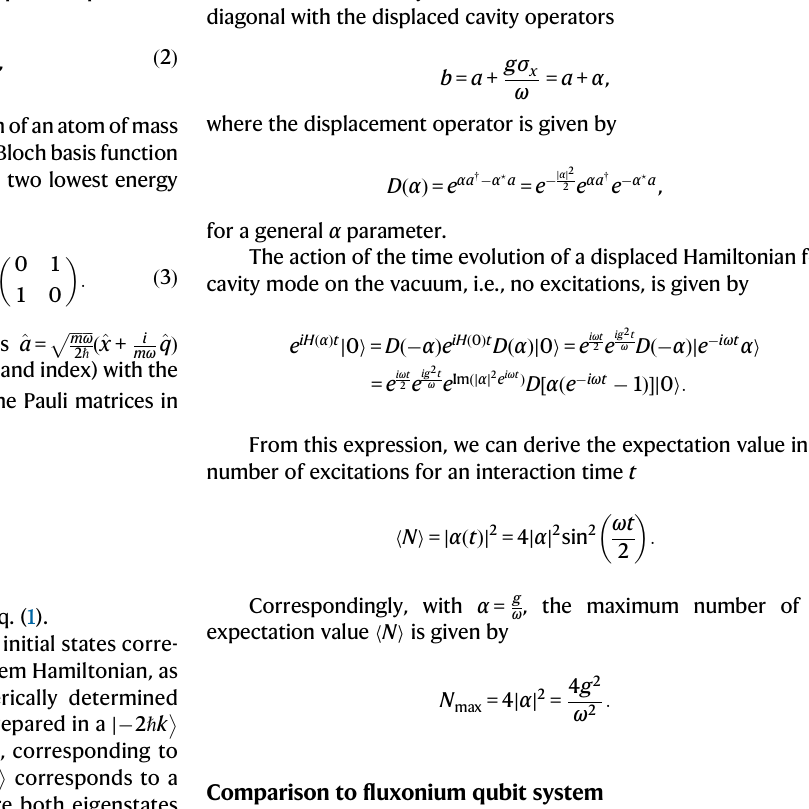
=0Hz is showninblue color,andthecaseof ω q number n .The case of ω q (cid:8) 2 π is shown in orange. b Corresponding population distribution of the positive parity